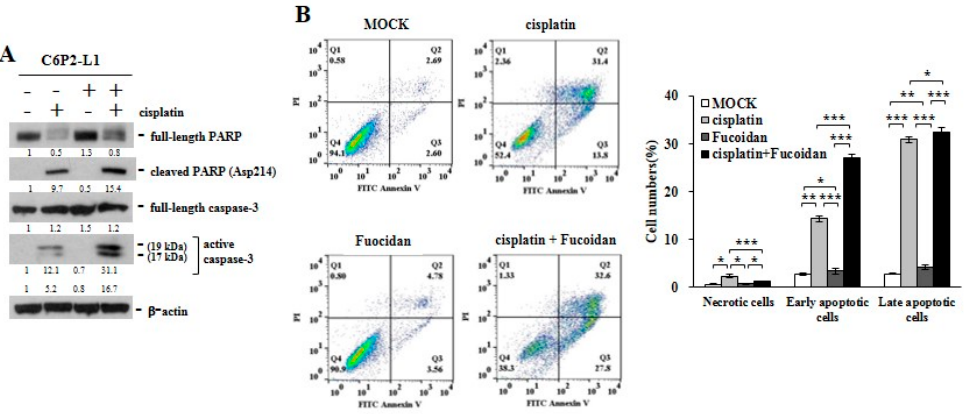
Figure 5. Oligo-Fucoidan and cisplatin cooperatively promote C6P2-L1 cancer cell death. Primary C6P2-L1 colon cancer cell were treated with cisplatin and/or Oligo-Fucoidan for 48 h. ( A ) The full-length PARP and cleaved PARP (Asp214) as well as the full-length capase-3 and active capase-3 were studied. ( B ) Cell death events were detected by FITC-conjugated Annexin V and PI staining, followed by flow cytometry analysis. Histograms show the percentages of necrotic and apoptotic cells in the indicated treatment.